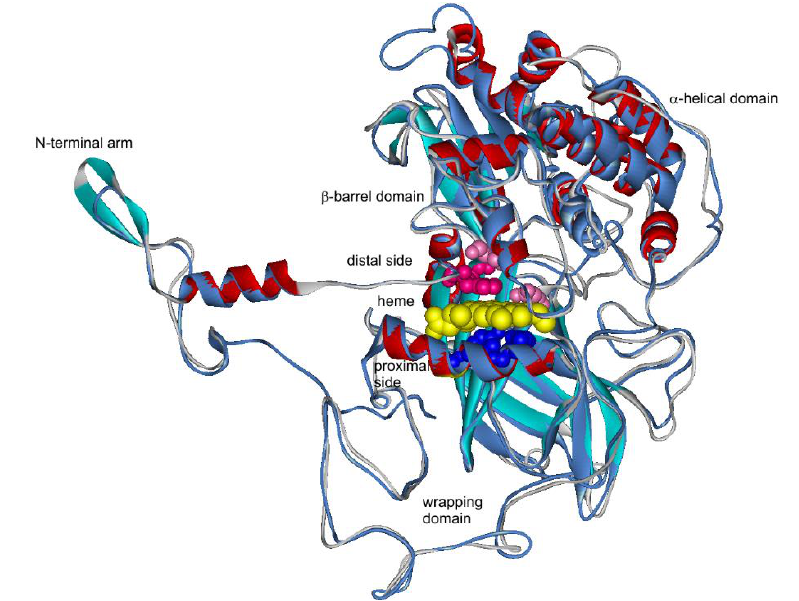
Figure 7. Structural model of a thermophilic heme catalase 2 secreted from Chaetomium thermophilum var. dissitum modeled with Phyre-2 server [16]. This structure was superimposed with MultiProt server [17] to the experimentally obtained structure with PDB code 1SY7 that represents NcKat1 of mesophilic Neurospora crassa [6].